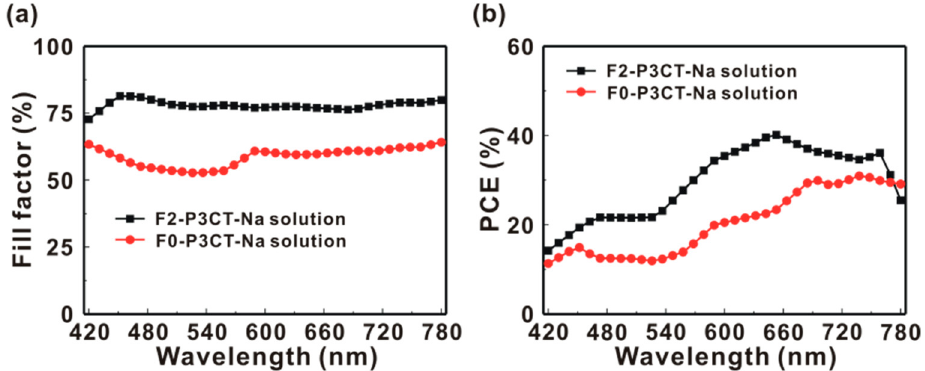
Figure 10. ( a ) Incident photon-to-current conversion efficiency spectra of the P3CT-Na based MAPbI 3 solar cells. ( b ) Integrated photocurrent density (J) of the P3CT-Na based MAPbI3 solar cells.